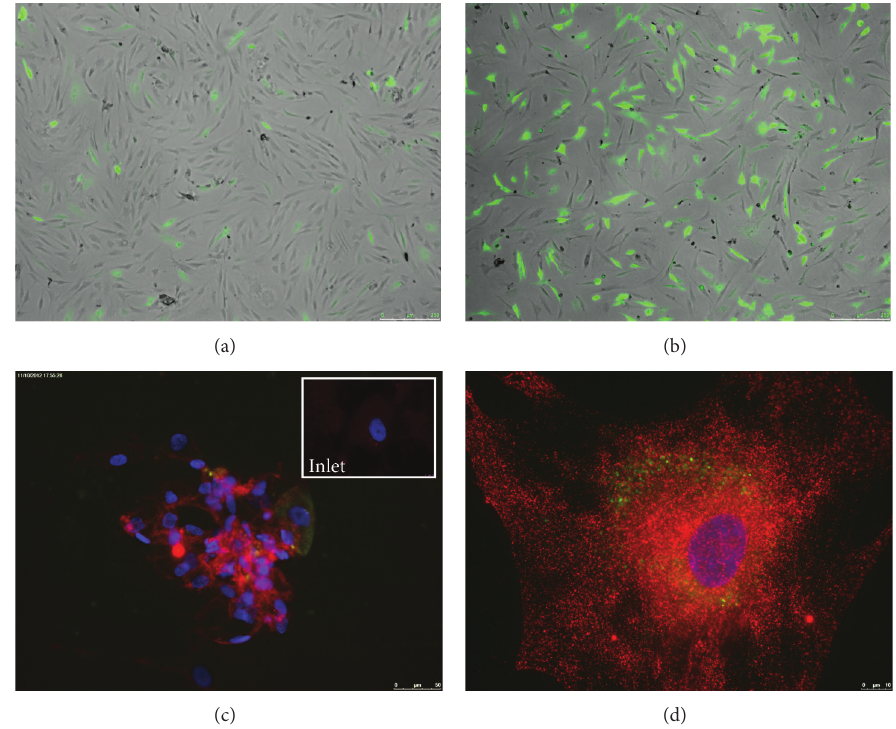
Figure 2: (a) and (b) pmaxGFP-transfected hMSC 48 hours after C-17 (a) or U-23 (b) electroporation using the Amaxa nucleofector. (c) and (d) GDF5 expression of transfected and control hMSC after 14 days of monolayer culture, anti-GDF5 antibody from GeneTex. Blue: cell nucleus stained by DAPI, green: translated GFP, red: intracellular GDF5. (c) Cell population at a resolution of 20x or (d) close-up (68x) hMSC transfected with RG207105, inlet in C = sham control.